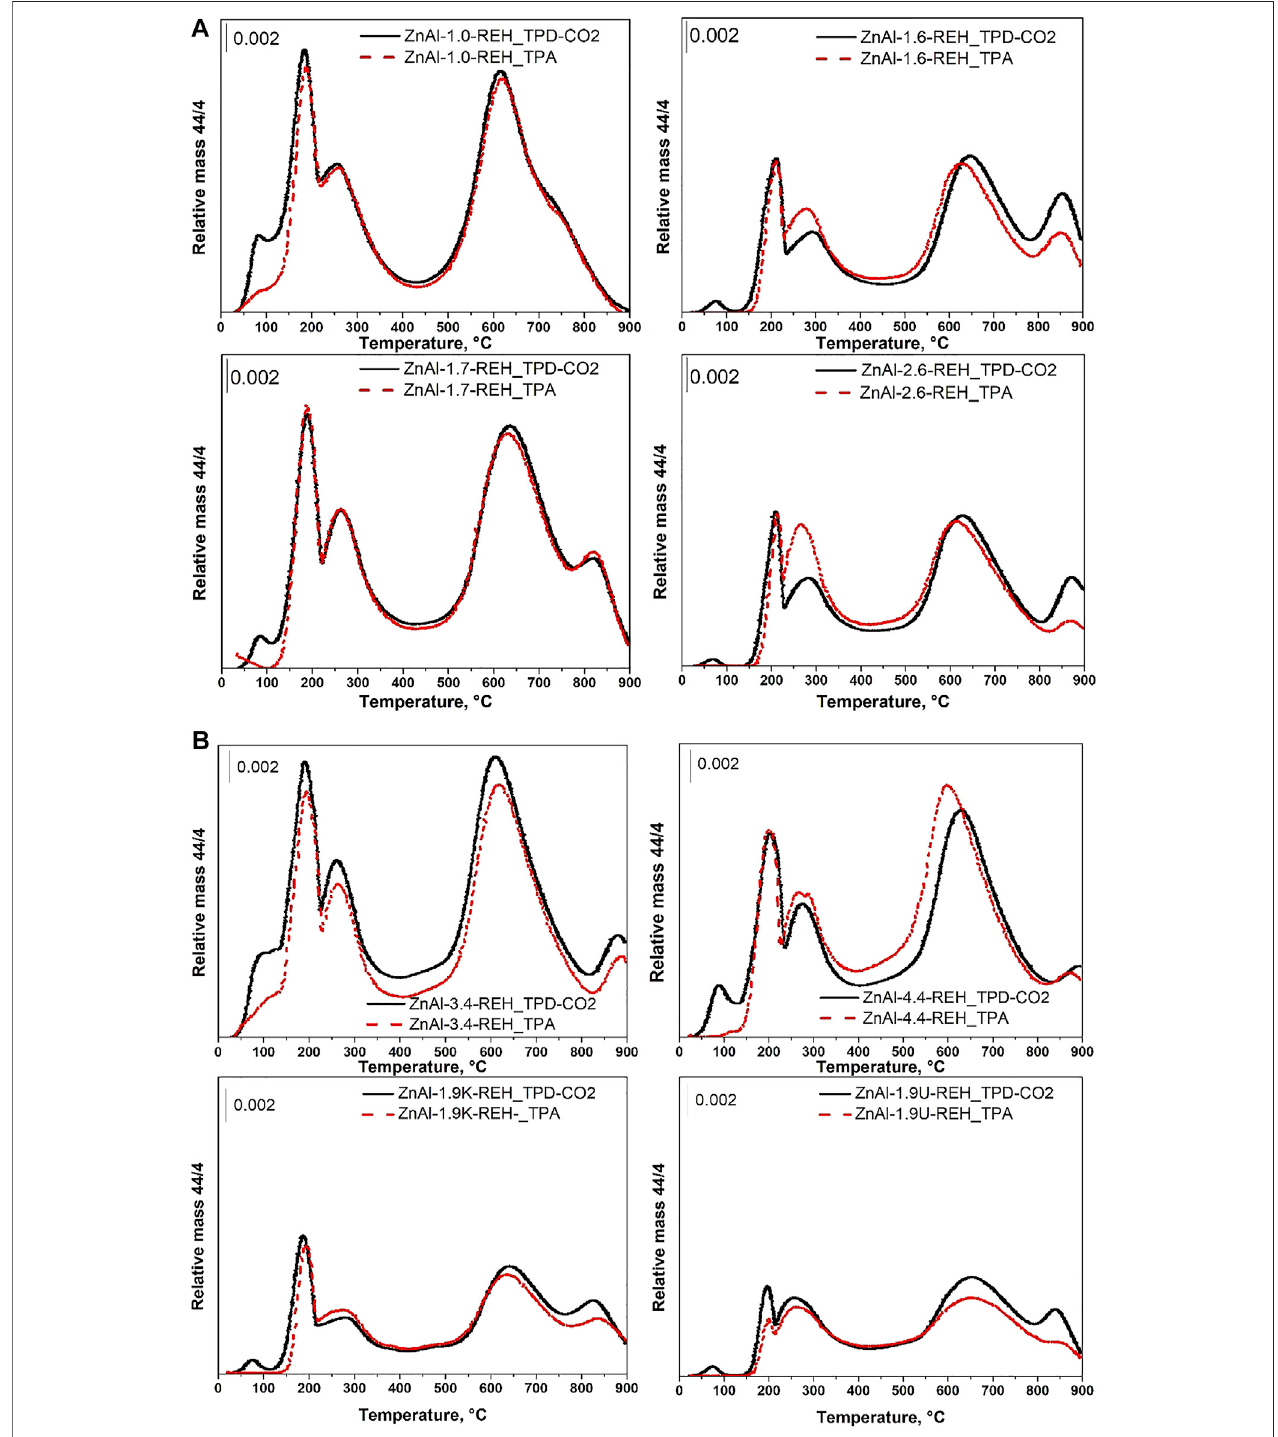
FIGURE 5 | (A) TPD-CO 2 and TPA (experiment without CO 2 adsorption) pro fi les of ZnAl RE-LDHs: ZnAl-1.0-REH, ZnAl-1.6-REH, ZnAl-1.7-REH, ZnAl-2.6-REH. (D) TPD-CO 2 and TPA (experiment without CO 2 adsorption) pro fi les of ZnAl RE-LDHs: ZnAl-3.4-REH, ZnAl-4.4-REH, ZnAl-1.9K-REH,